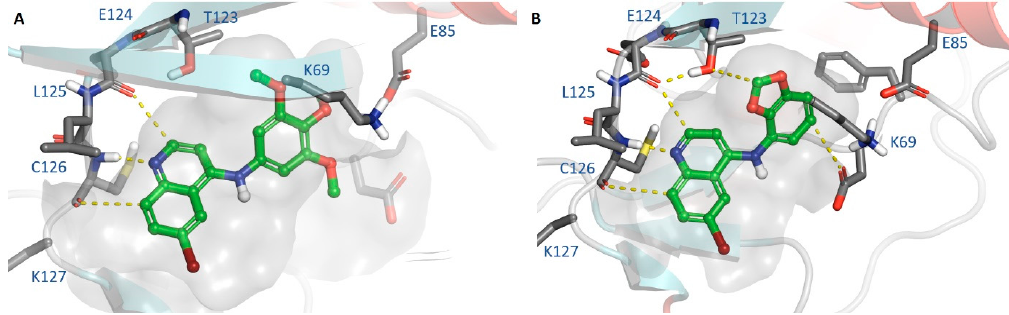
Figure 3. Docking of 1 ( A ) and 9 ( B ) into the ATP binding site of GAK (PDB: 5Y7Z). The protein is shown as a ribbon view with key amino acids as sticks with carbon atoms in grey, nitrogen in blue, oxygen in red, and sulphur in yellow. The GAK inhibitor is shown as sticks with carbon atoms in green, nitrogen in blue, and oxygen in red. The ATP-binding pocket is shown in light grey. Hydrogen bonds from the hinge residues to the inhibitor are highlighted as yellow dashed lines.